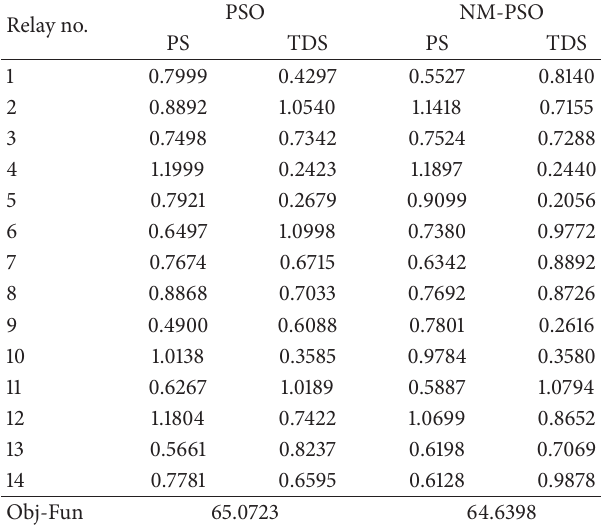
Table 6: Results of a conventional PSO and the proposed NM-PSO in variable network topologies.